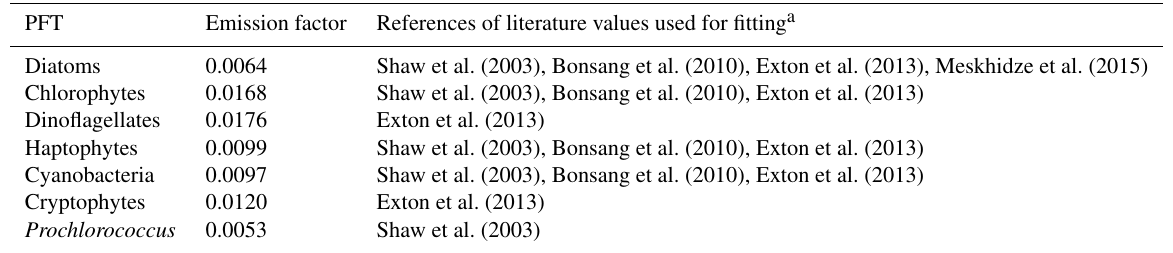
Table 2. Emission factor (EF) of each PFT determined by applying a log-squared relationship between light intensity and isoprene production rates resulting from published phytoplankton culture